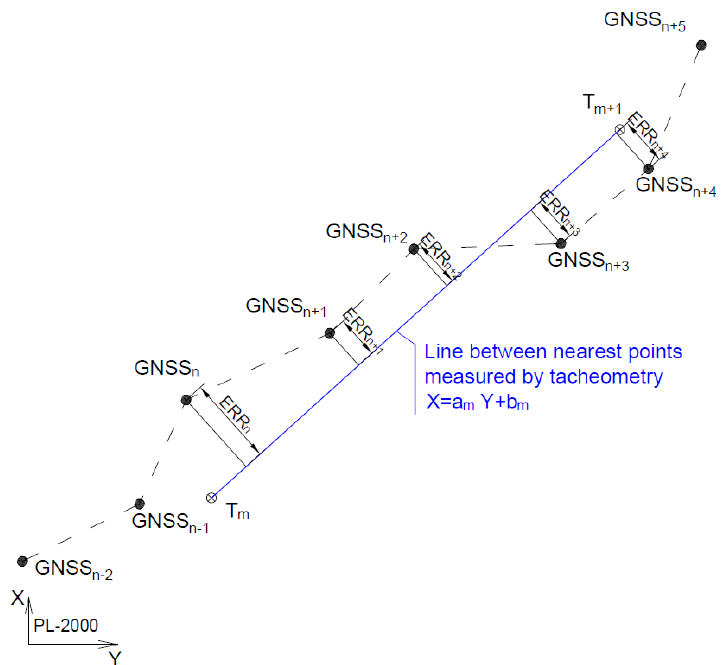
Figure 11. Relative horizontal errors for all points from GNSS kinematic terms relative to straight lines connecting the positions obtained from tacheometry.